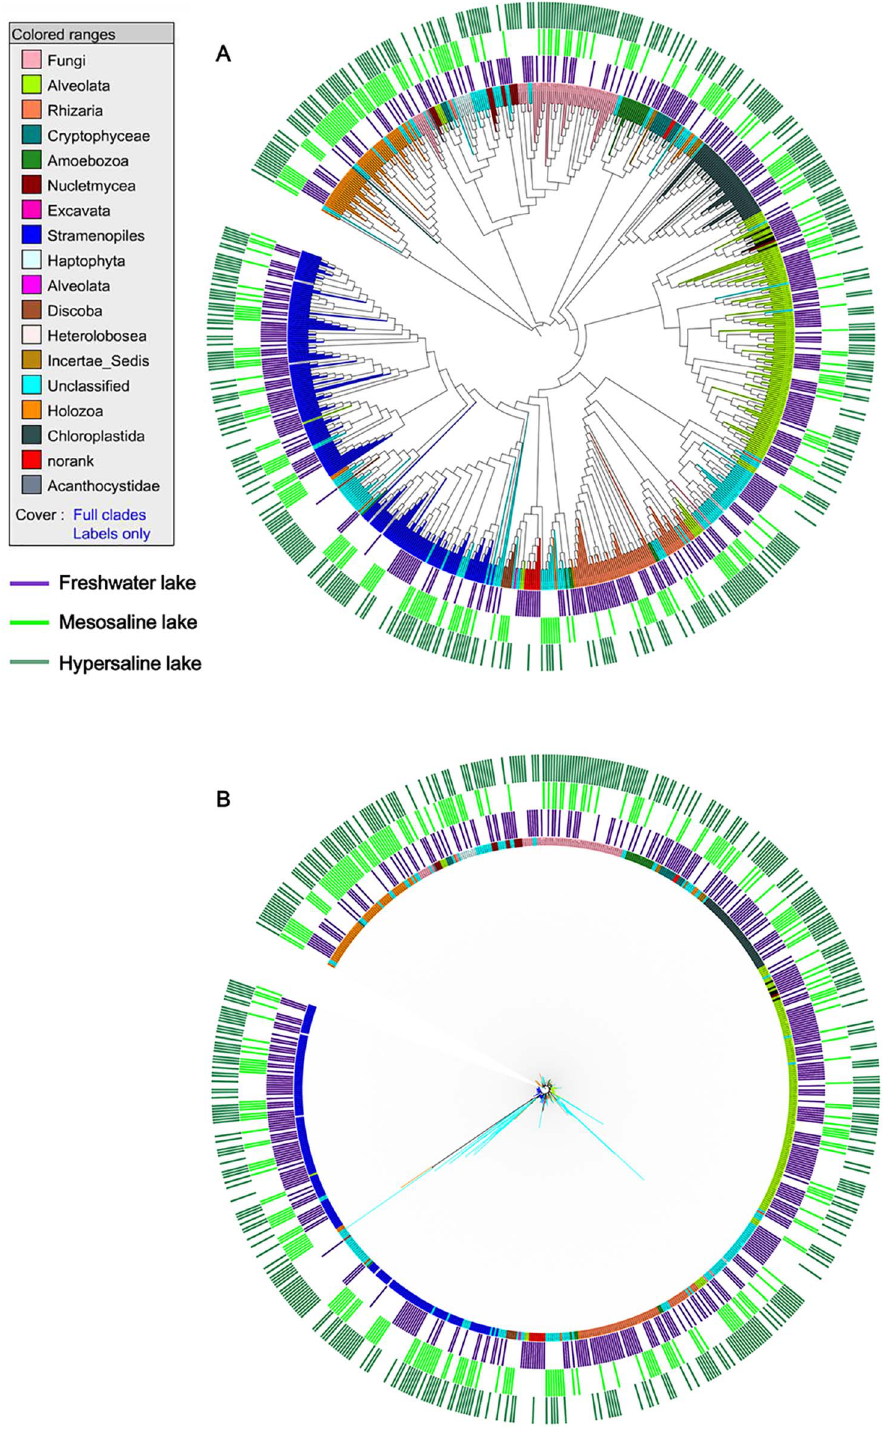
Figure 3. ML phylogenetic tree with 18S rDNA sequences of eukaryotes retrieved from the investigated lakes in the Qaidam Basin. The tree was constructed using 733 sequences. (A) Tree ignoring branch lengths and overlaid with colors with independent taxonomic assignations of sequences to an eukaryotic supergroup. The branches with cyan colors correspond to unclassified eukaryotes. (B) Same tree showing branch lengths, colored as before. The scale bar indicates 0.1 substitutions per position. highly unique branches in this phylogenetic analysis (Figure 3B). mesosaline, and freshwater lakes tended to form separate groups Phylogenetic analysis indicated that most OTUs from hypersaline, and shared rather low similarities (Figure 3).